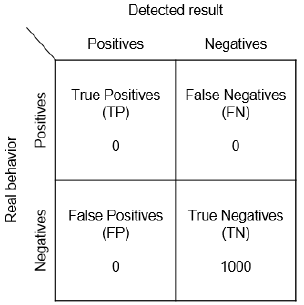
Figure 14. Recording and use confusion matrix.